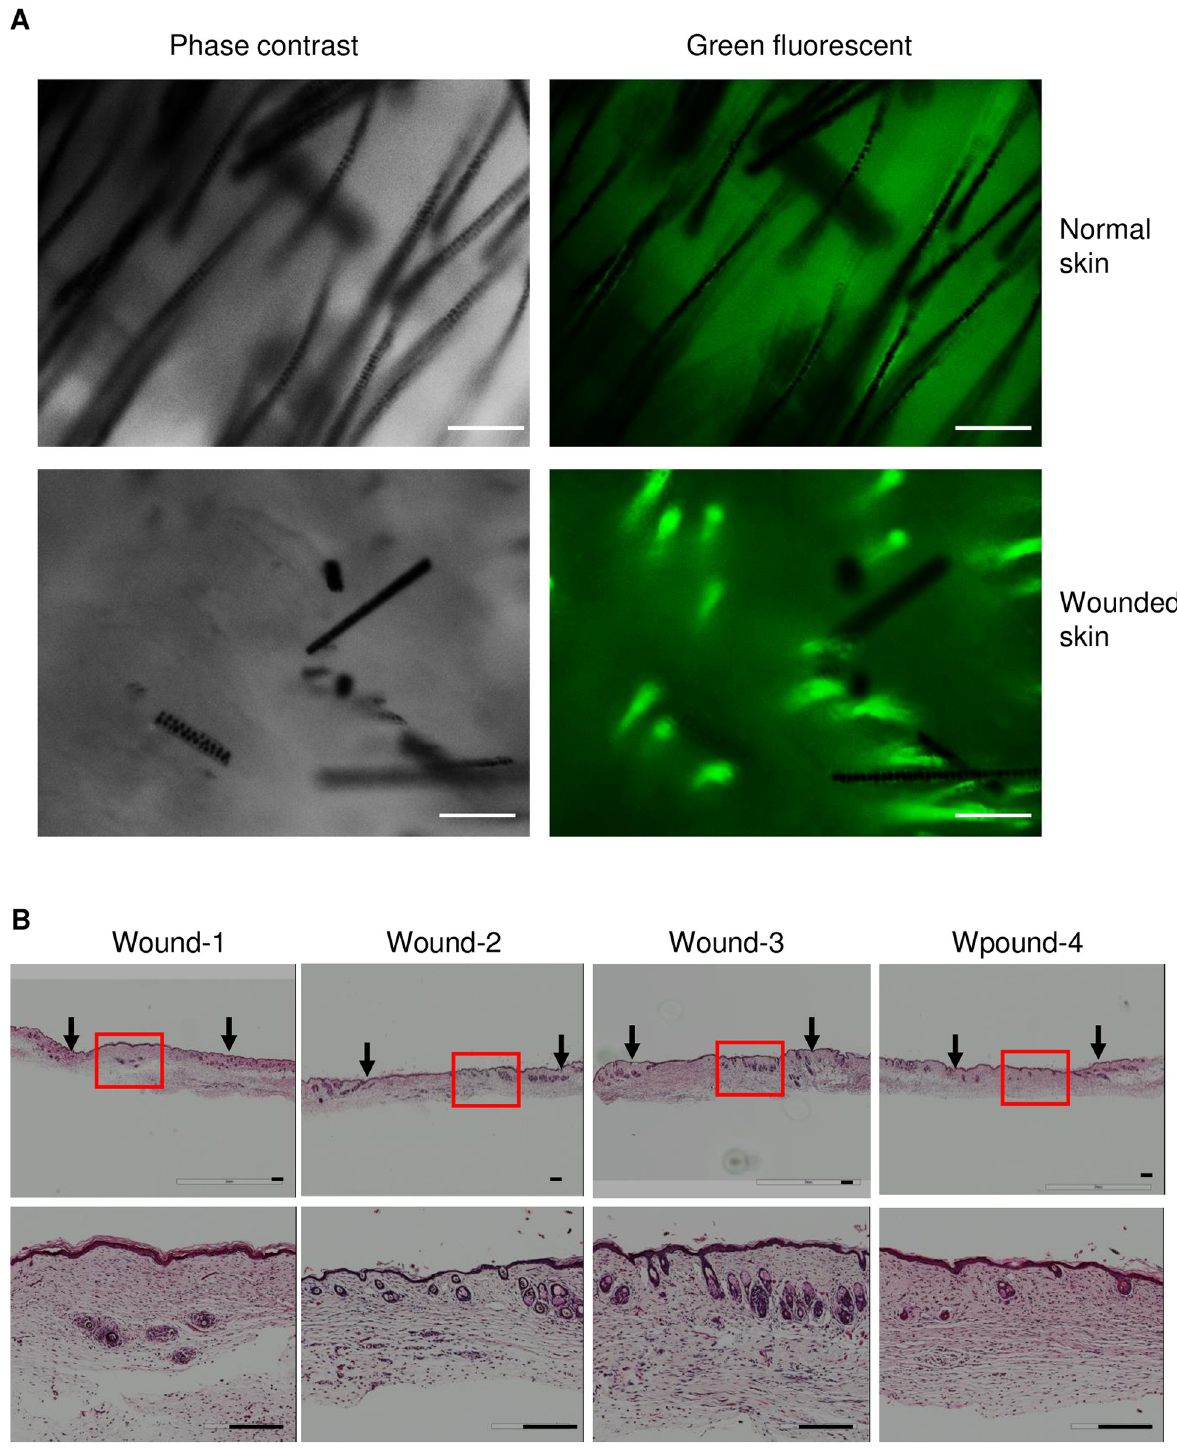
Fig 6. Hair follicle-like structures are seen in wounded skin of mice received GFP-expressing myeloid cells for 4 weeks. Eight millimeters punch biopsies of excisional wounds were created in C57BL/6 mice received one million GFP-expressed splenocyte-derived myeloid cells simultaneously. Four weeks after wounding, mice were euthanized, wounded skin were collected for examination of new hair follicle regeneration. ( A ) Images were taken under the fluorescent microscope in normal and wounded skin of the same mice received one million cells for 4 weeks. ( B ) H & E staining in wounded skin of mice received one million cells for 4 weeks. Arrows indicate wounding area. Top panels, magnification of 20 × ; Low panels, magnification of 100 × . Scale bars, 100 μ m. https://doi.org/10.1371/journal.pone.0262060.g006 PLOS ONE | https://doi.org/10.1371/journal.pone.0262060 June 23,